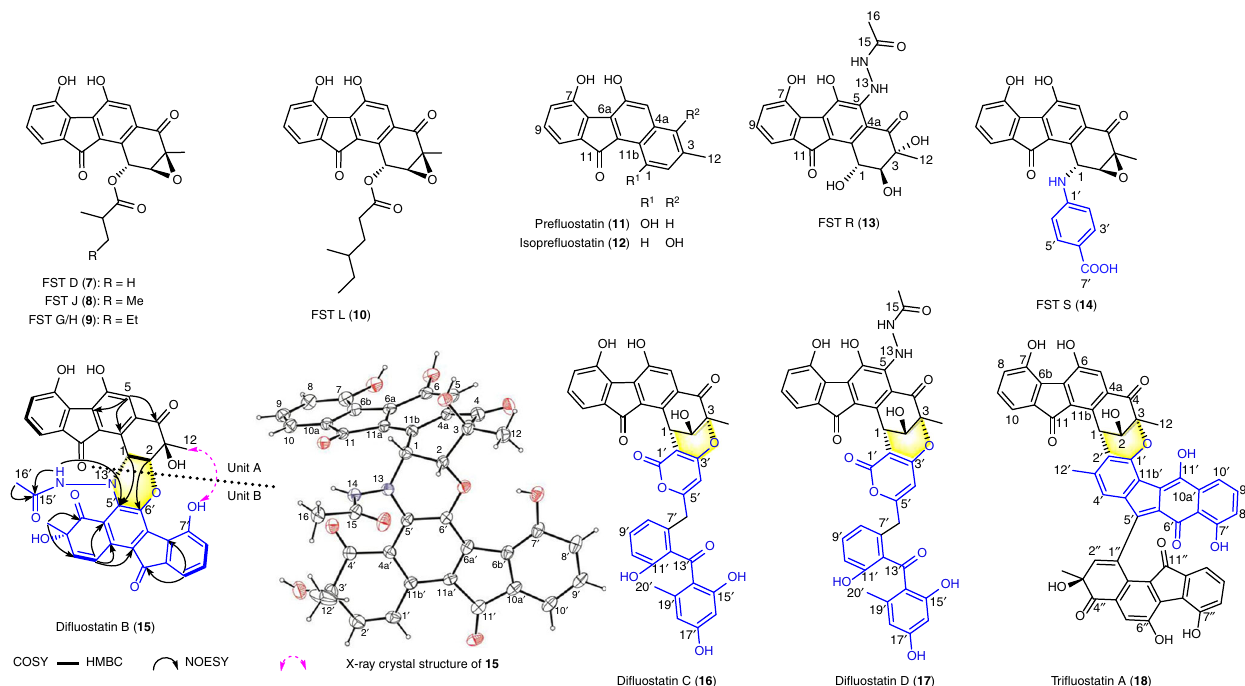
Fig. 2 A partial list of FST-related metabolites isolated from the heterologous host S. albus J1074 harboring the fl s gene cluster. Selected COSY, HMBC, and NOSEY correlations and the X-ray crystal structure of di fl uostatin B ( 15 ) are also shown. In dimeric compounds, the acceptors and donors are shown in black and blue, respectively. A full list of structures of compounds isolated in this study is provided in Supplementary Fig.